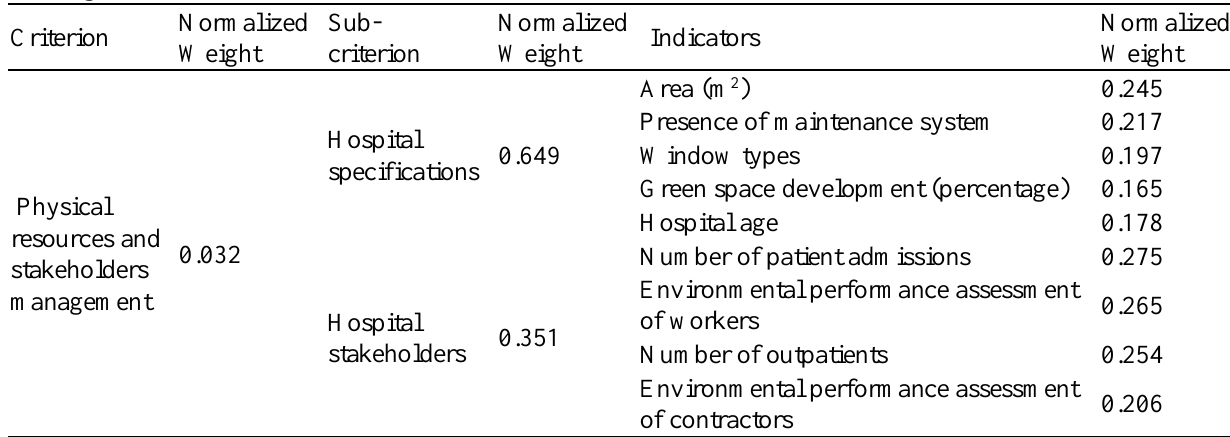
Table 7. Physical resources and stakeholder management sub-criteria, indicators and corresponding